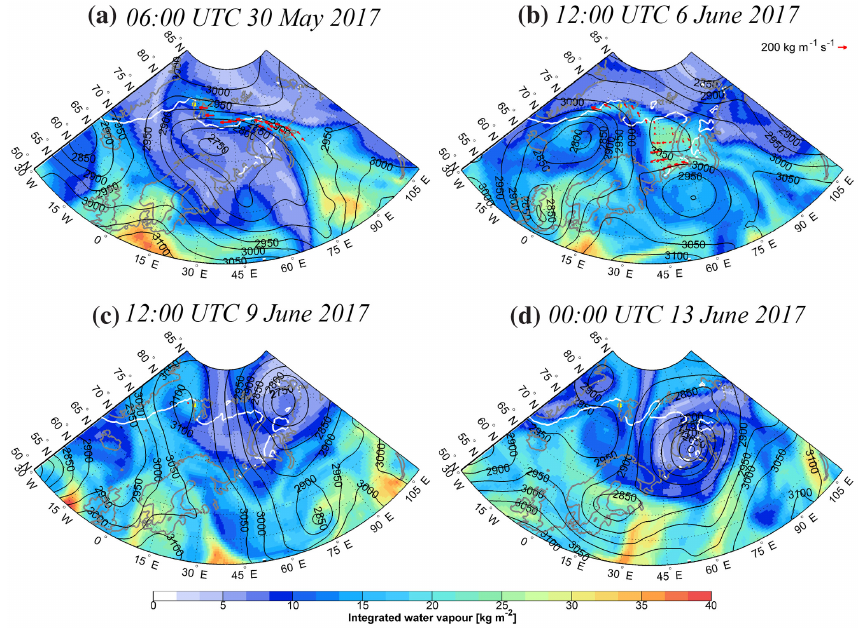
Figure A1. Vertically integrated water vapor (IWV; in kgm − 2 ; shading), 700hPa geopotential height (in meters; black contours), and sea ice edge (defined by 15% concentration; white line) for (a) 06:00UTC on 30 May, (b) 12:00UTC on 6 June, (c) 12:00UTC on 9 June, and (d) 00:00UTC on 13 June 2017, based on ERA-I data. In panels (a) and (b) , red arrows indicate the IWV transport (IVT; in kgm − 1 s − 1 ) within the atmospheric rivers affecting Ny-Ålesund.